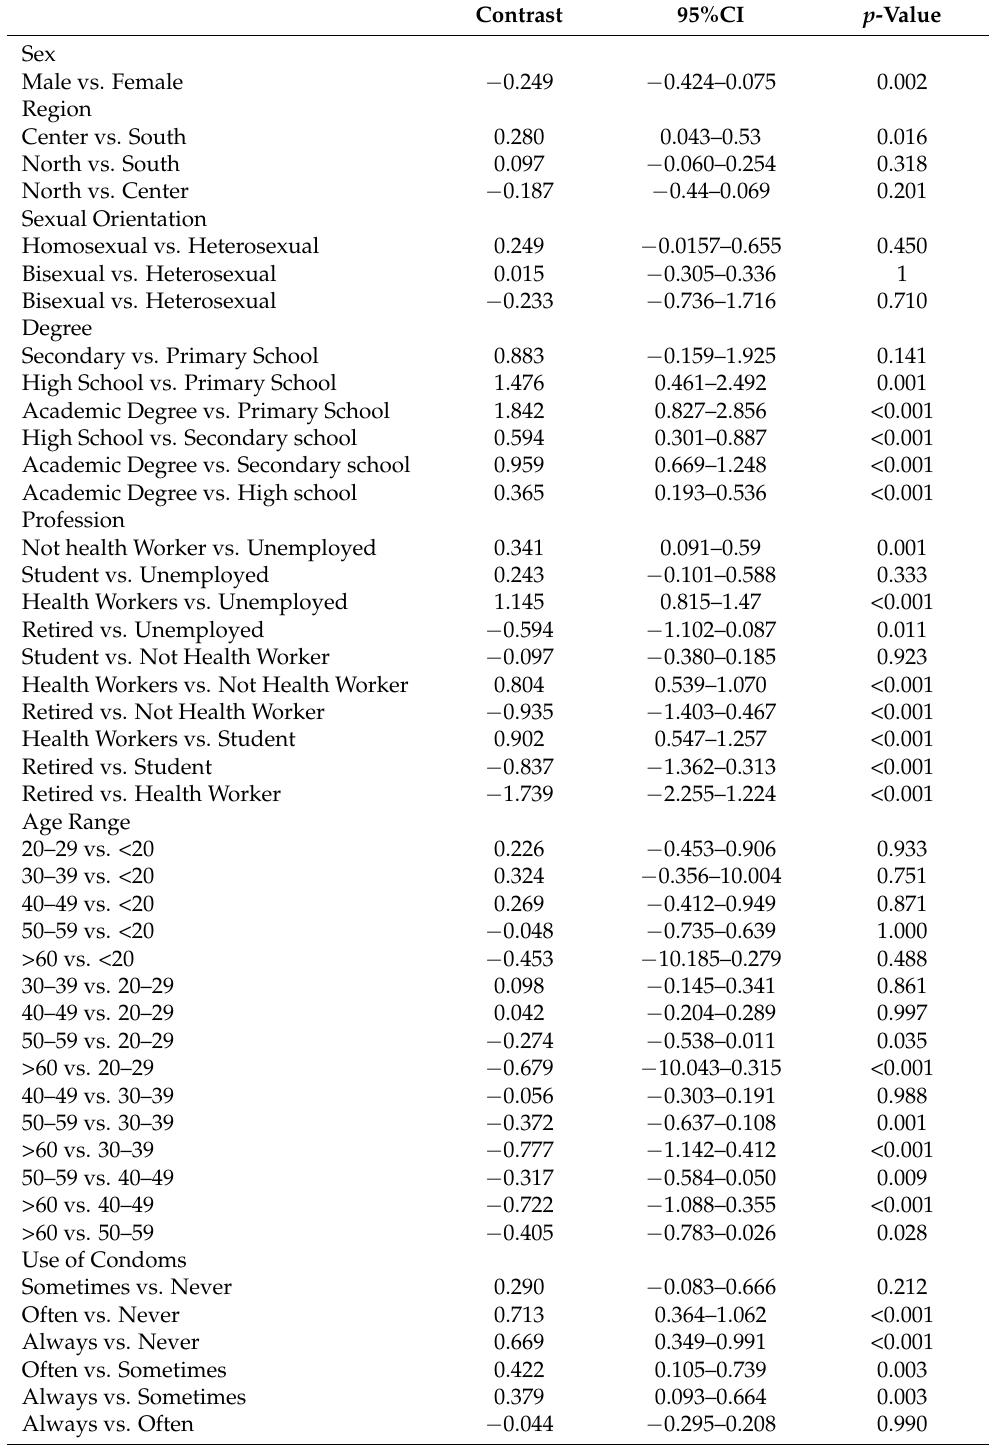
Table 2. Questionnaire scores comparison of 2183 participants according to demographic, occupation, level of education, and sexual